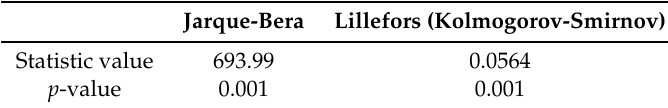
Table 2. Normality tests of temperature data in Arezzo (Tuscany),